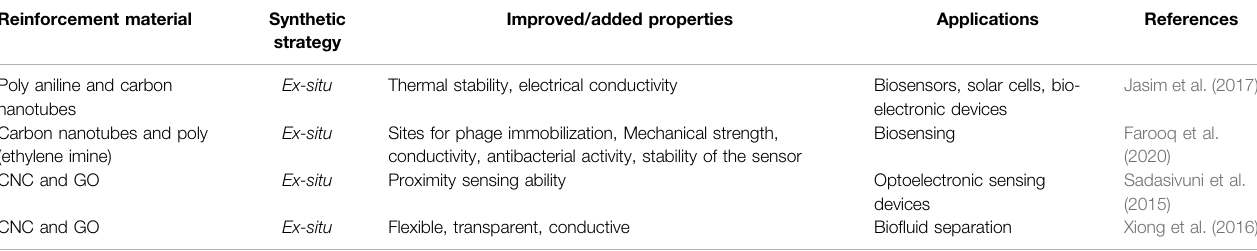
TABLE 7 | The improved properties and biosensing applications of different nanocellulose-based composites. Reinforcement